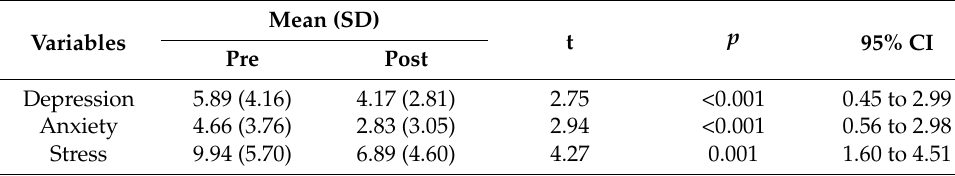
Table 3. Effects of application use on psychological